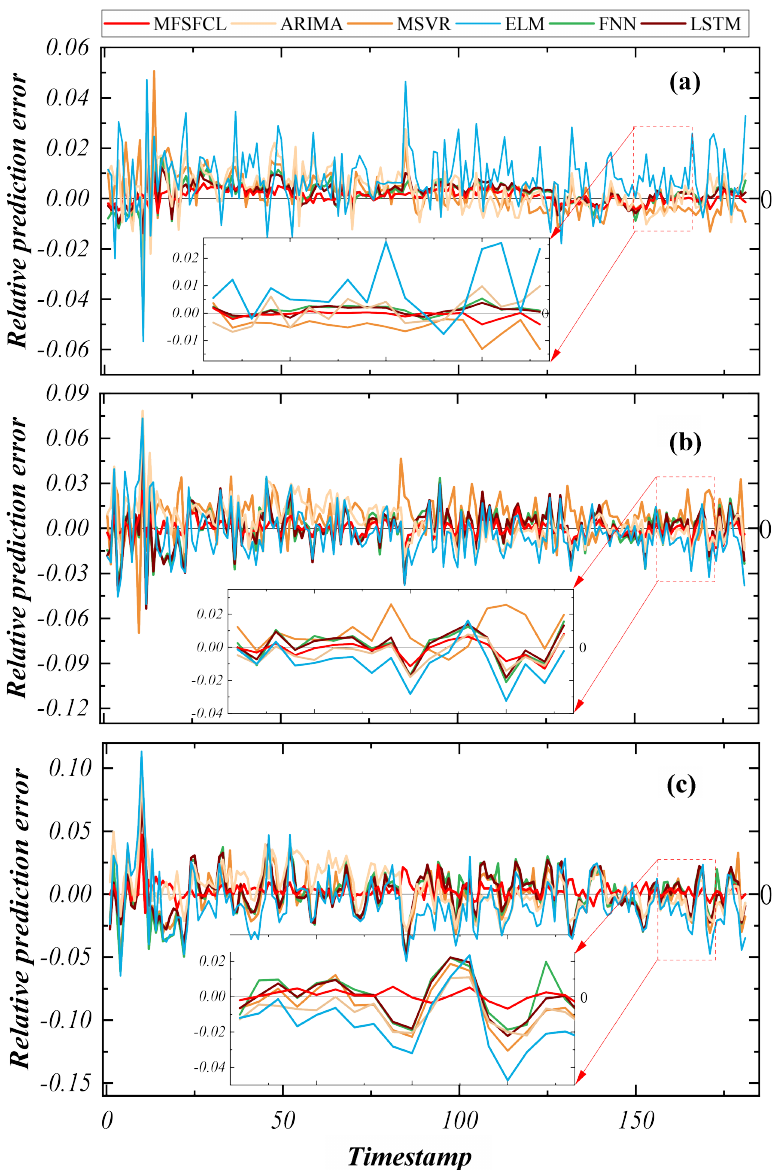
Figure 7. The relative prediction errors of different forecasting models for different days; ( a – c ) depict the relative prediction errors of day 1, day 2, and day 3,